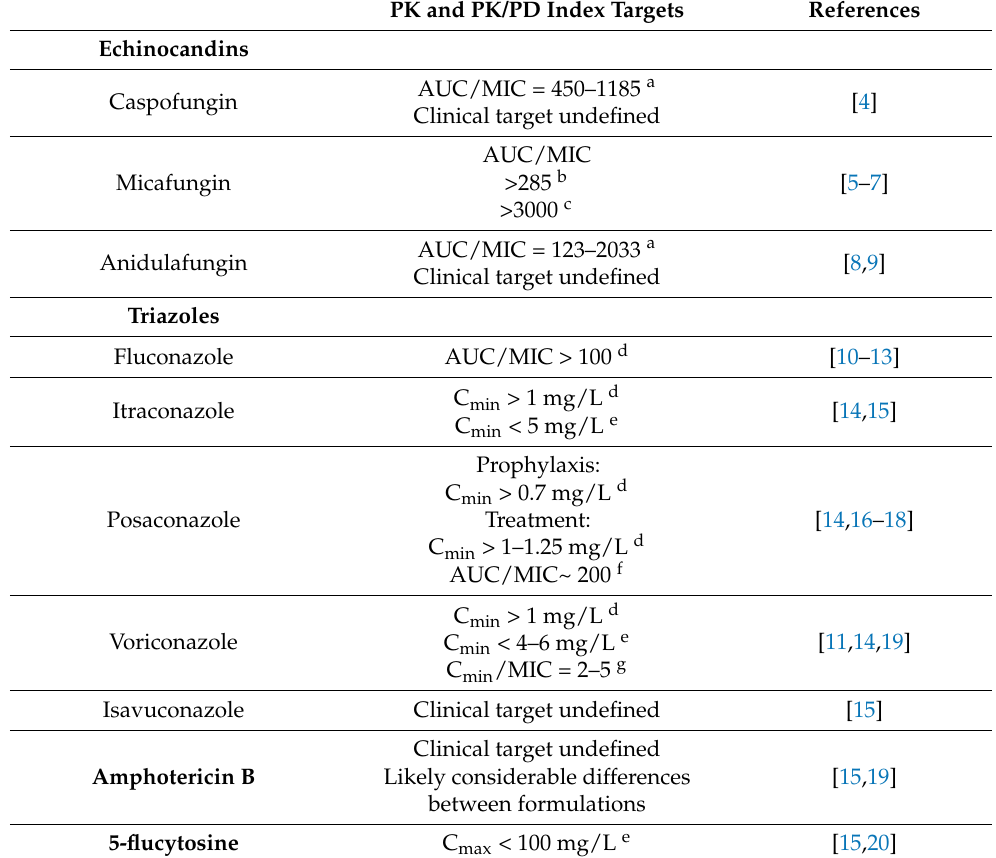
Table 1. TDM of antifungal